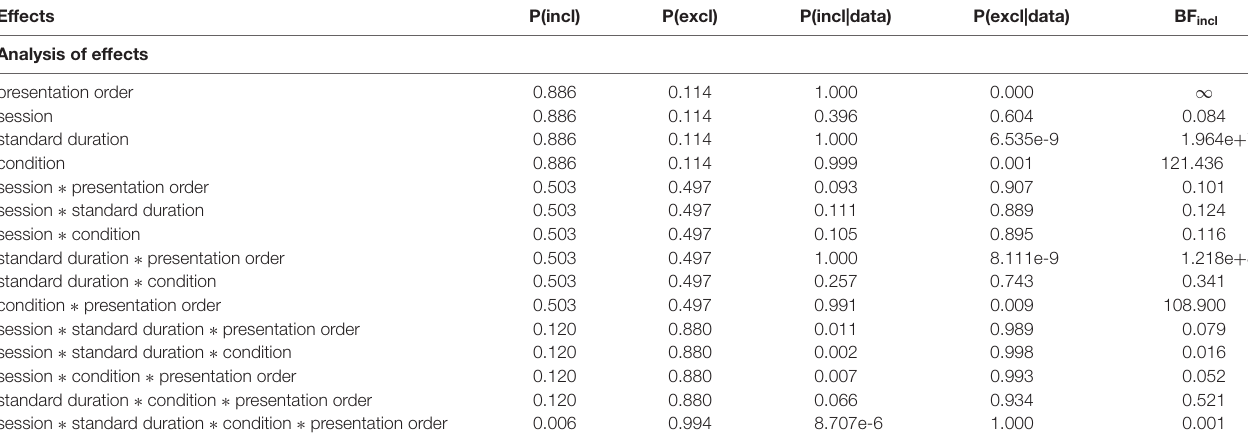
TABLE 3 | Bayes factors for inclusion calculated based on Bayesian model averaging for PSEs of Experiment 2.